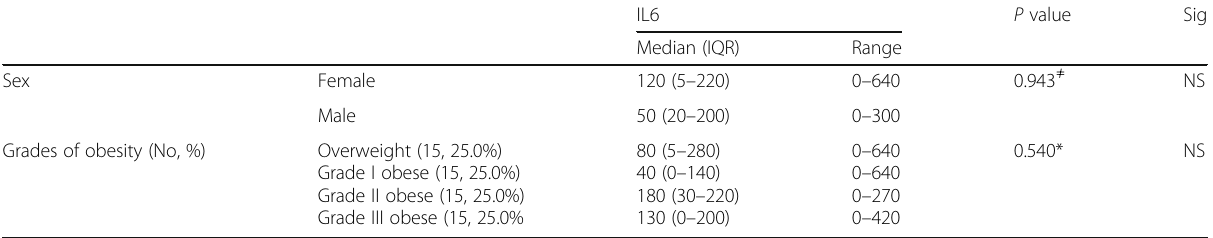
Table 4 Comparison of circulating levels of IL6 between both sexes of subjects with overweight and different grades of obesity